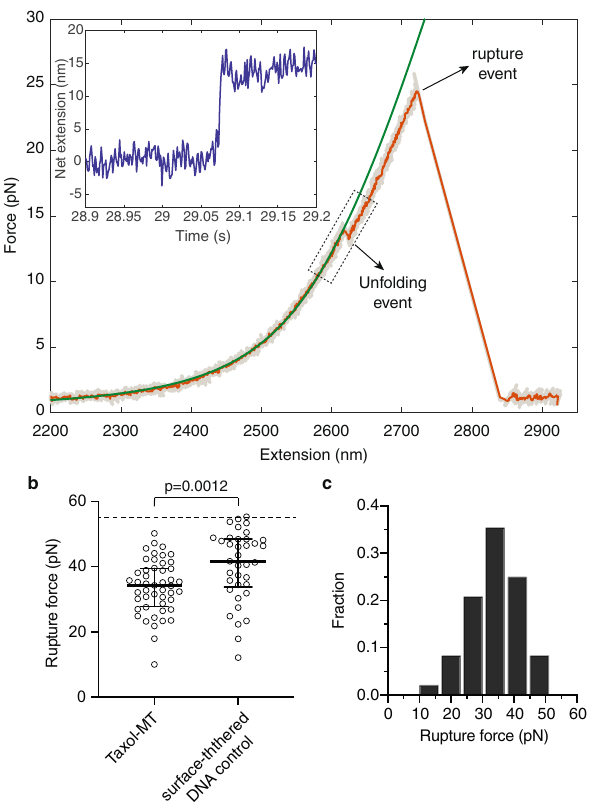
Fig. 3 Pulling tubulin subunits from the taxol-stabilized microtubule lattice with an optical trap. a Example of a force-extension curve from the tubulin-pulling assay. Unfolding and rupture events are indicated by arrows. Experiments were performed with a constant pulling velocity of 0.32 μ m/s, using an 8.2 kb-DNA-linker (contour length 2.8 μ m). Gray: raw trace; orange: median- fi ltered trace; green: worm-like chain model fi t up to the unfolding event. Inset: the extension after subtracting the extension of DNA linker showed a clear unfolding step of ~15 nm. The corresponding region of the force-extension curve is marked by a rectangle. b Rupture forces from the taxol-MT pulling traces were signi fi cantly lower than the ones from the surface-tethered DNA linker controls ( n = 48 and 37 events for taxol-MT and control traces respectively; p = 0.0012, two-tailed Mann-Whitney U test). Error bars: median, 25th and 75th percentiles. Note that the average rupture forces measured from the linker-only control were likely to be an force that could be generated by our optical trap (~55 pN; dashed line in Fig. 3B). c Rupture-force histogram in the taxol-stabilized microtubule pulling experiments ( n = 48 rupture